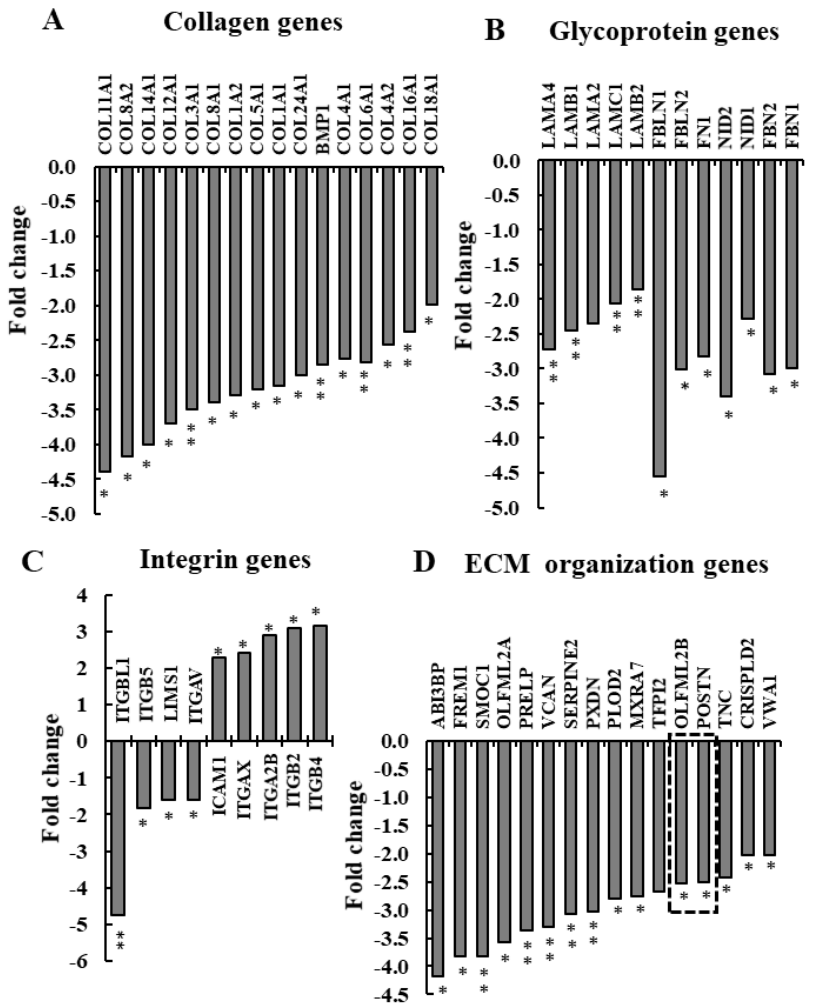
Figure 3. Differentially expressed ECM structure ‐ related genes of murine origin. ECM structure ‐ related genes found to be enriched using DAVID Gene Ontology analysis are presented as the fold change of the expression in si ‐ hVDAC1 ‐ 2A ‐ TTs relative to si ‐ NT ‐ TTs. ( A ) Collagen genes. ( B ) Glycoprotein genes. ( C ) Integrin genes. ( D ) ECM organization genes. In all cases, * p ≤ 0.05, ** p ≤ 0.01. Two selected genes, periostin and tenascin C, whose expression was further analyzed at the protein level (Figure 3), are indicated by the dashed frames.